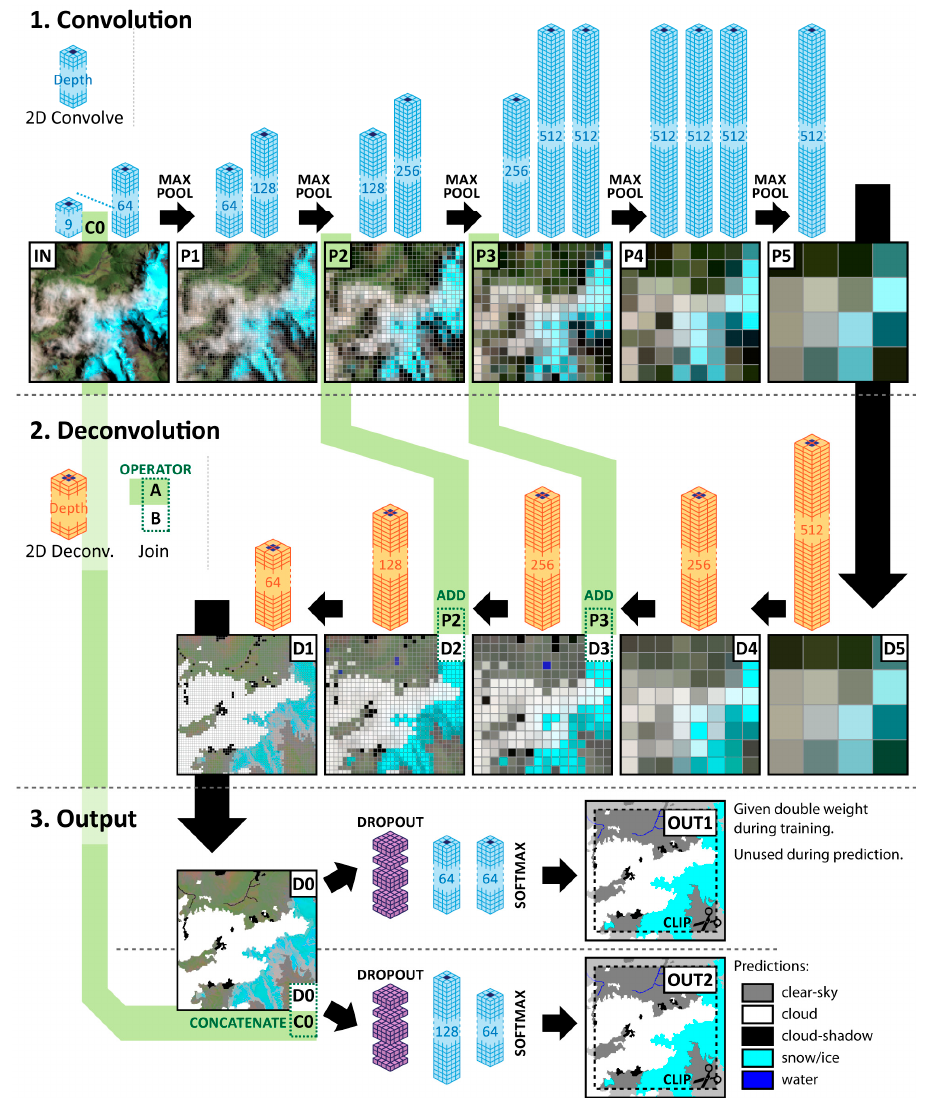
Figure 2. Convolutional neural network (CNN) architecture for the cloud and cloud-shadow screening task. In phase one, increasingly complex spatial features are extracted by a series of two-dimensional convolution layers (blue) and max pooling. Blue numbers within convolutional blocks denote the number of features each convolutional filter uses. For each labeled image (IN, P1-P5), the resolution is half of the one preceding it. In the second phase, these features are used to reconstruct the spatial resolution through a series of deconvolution layers (orange), with selected earlier layers (P2, P3) summed into outputs to contribute earlier detail (green). In this phase, the resolution of images re-doubles between numbered images (D5–D0). In the final phase, two outputs are predicted, one from only the deconvolution output (OUT1) and one that also combines fine-scale features from early in the network to ensure fine-scale predictions (OUT2); only the second output is used during prediction. Outputs are clipped to remove a 28 pixel border from all